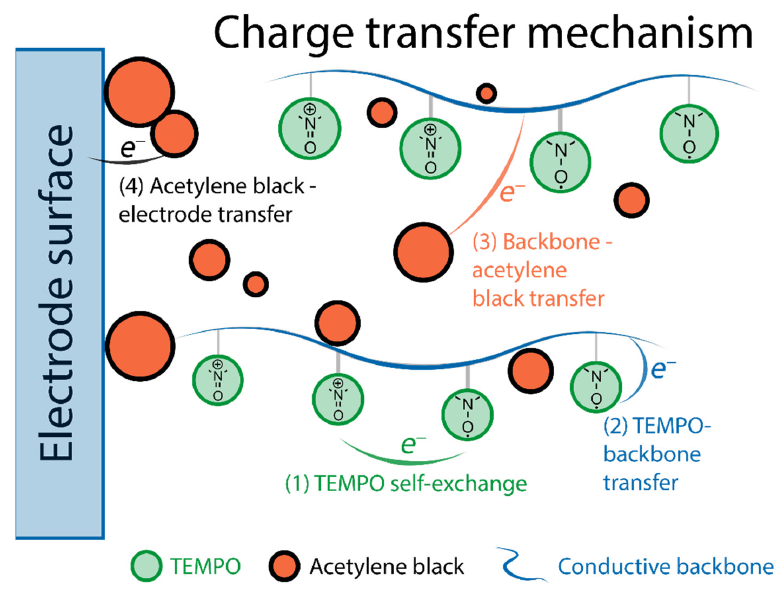
Figure 6. Schematic illustration of the charge transfer process in TEMPO-modified polypyrrole. Polypyrrole is deemed to be an electric conduction path that assists repeatable oxi- dation/reduction through aggregated radical polymer bulks. The internal charge transfer between the TEMPO pendant groups and the backbone has also been observed in the case of TEMPO-modified 3,4-propylenedioxythiophene (ProDOT) [74], though the precise ef- fect of such interaction was not firmly established.